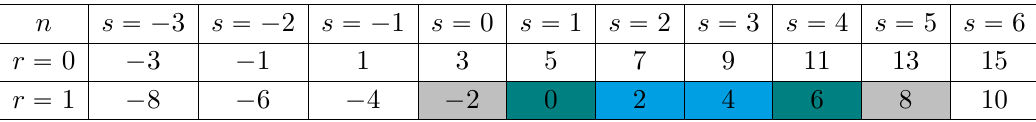
Table 1 . Values of the momentum n of some operators in the p 2 , 5 q compact linear dilaton. The correct fusion range for M 1 , 2 (cid:2) M 1 , 2 is shaded in blue and green. The gray shaded boxes correspond to the operator V 3 , 5 which seemingly violates the fusion